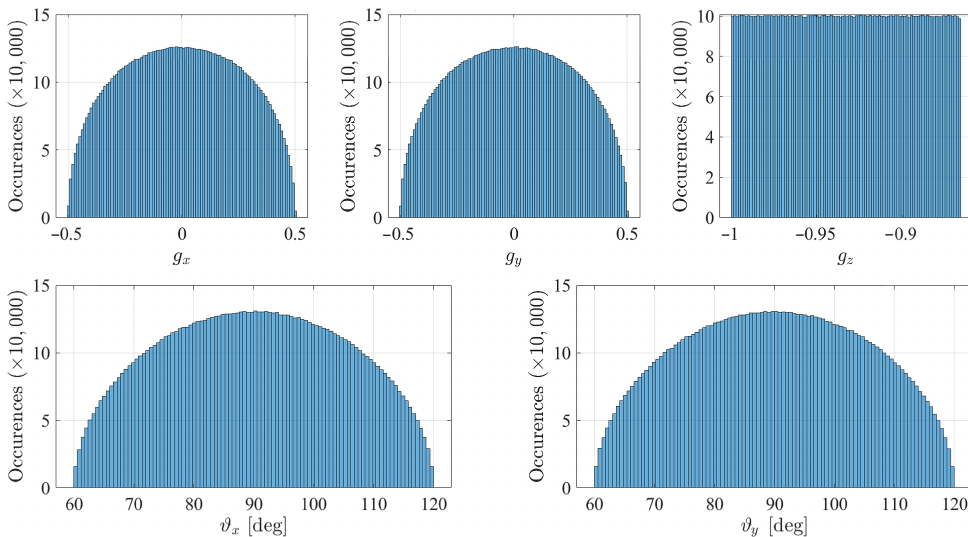
Figure 3. Monte Carlo tests: histograms of the angles and the gravity